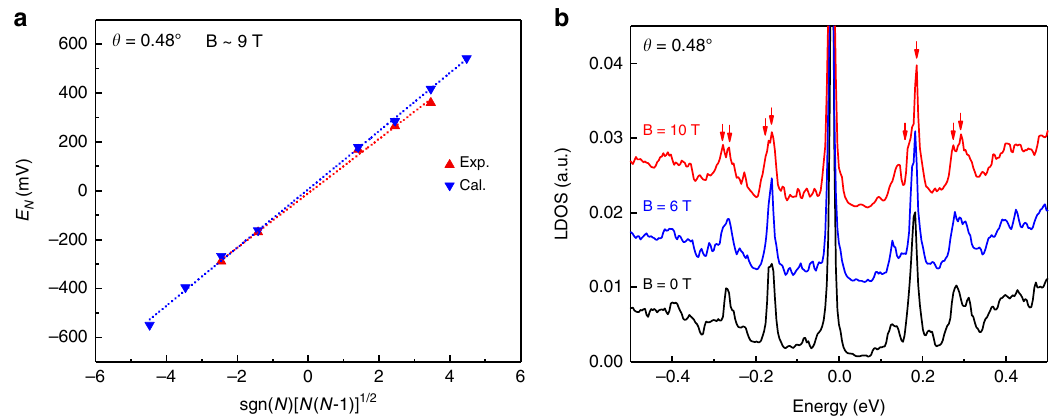
ffiffiffiffiffiffiffiffiffiffiffiffiffiffiffiffiffiffi p N ð N (cid:4) 1 Þ and the obtained